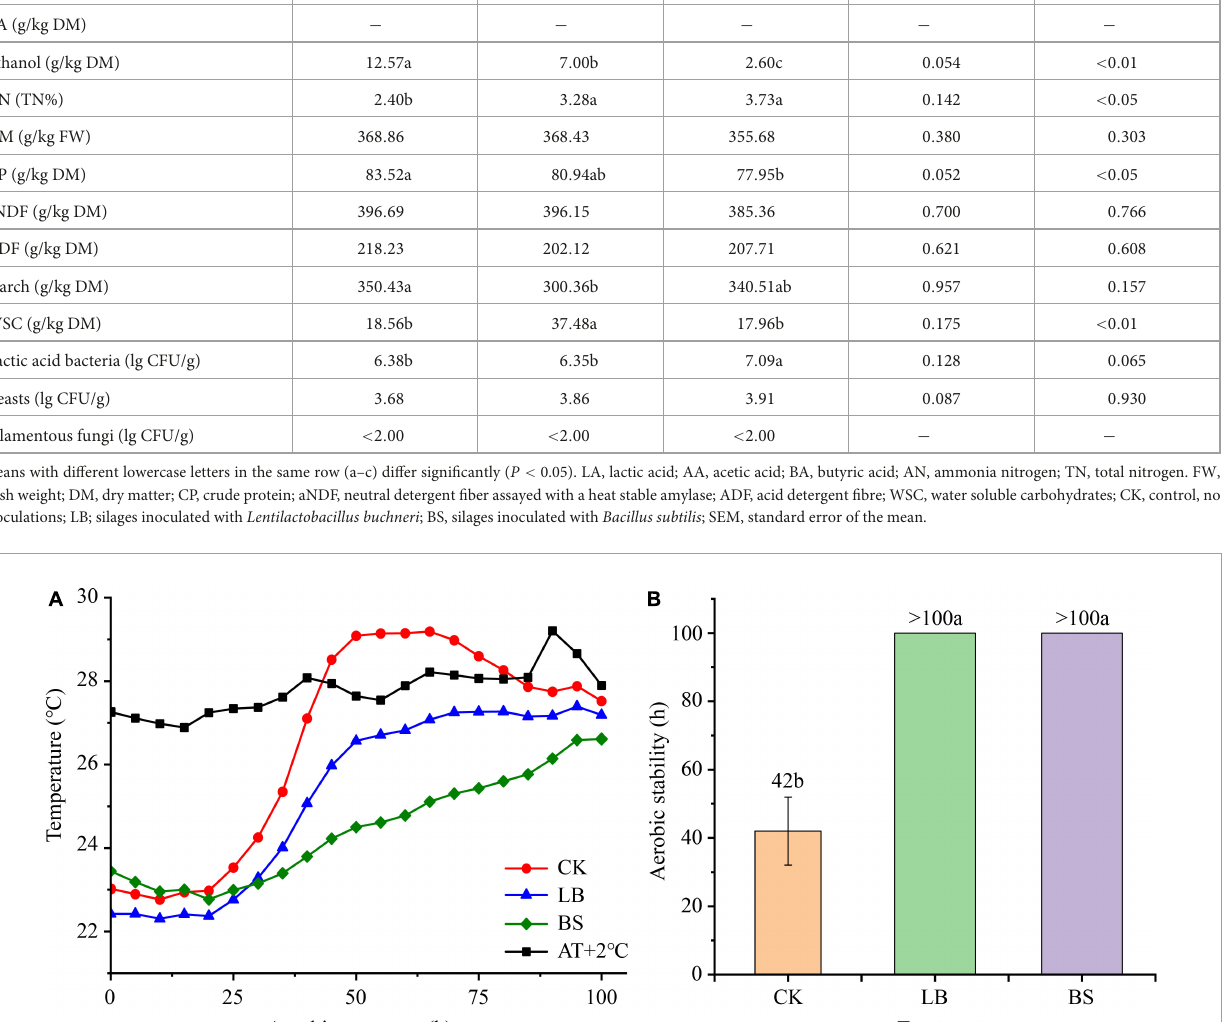
abundance of Kazachstania gradually increased during aerobic exposure, but the relative abundance of Kazachstania in the LB and BS groups were lower than those in the CK group at AS0 and AS1. At AS0, the CK group was dominated by fungi such as Kazachstania and Pichia , Candida accounted for a large proportion in the LB treatment, the relative abundances of Papiliotrema and Hannaella in the BS group accounted for the largest proportions, and the relative abundance of Issatchenkia in the BS group was higher than those in the other treatments at AS2 ( P < 0.05; Figure 7C